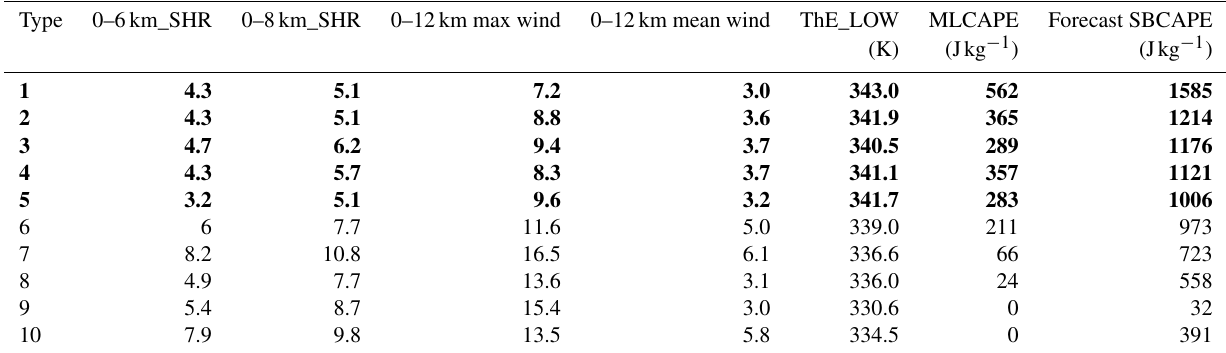
Figure 1. WSR-88D sites contributing to the Miller and Mote (2017) WFT climatology. Table 1. Kinematic and thermodynamic parameters of 12:00UTC composite soundings from Atlanta, GA, USA, for each radar-identified morphological type in Miller and Mote (2017). Morphological types classified as WFTs are bolded. All kinematic values are shown inms − 1 , whereas the units of the thermodynamic parameters are provided in the table. Explanations for the variable abbreviations can be found in Table 2 and Appendix